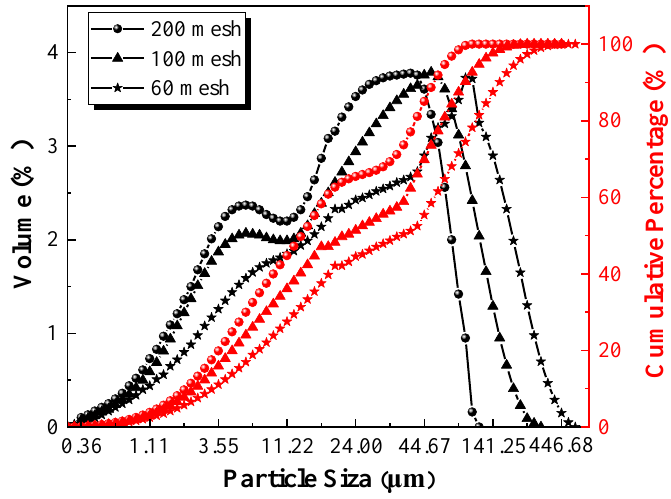
Figure 7. Particle size distribution of CACG at different levels of particle fineness. Table 7. Parameters of the CACG at different levels of particle fineness. Specific Surface Parameters Span Uniformity Area (m 2